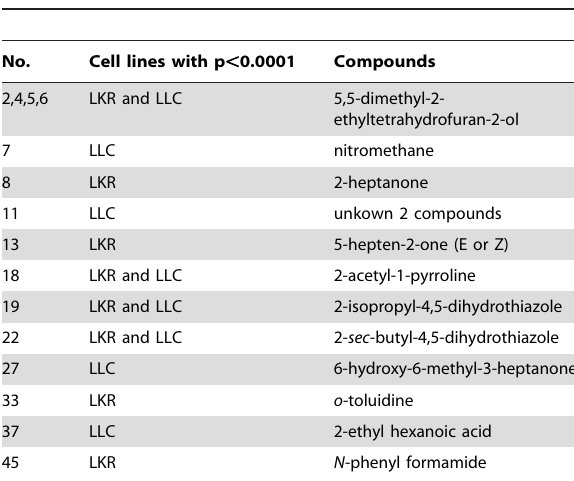
Table 1. Selected peaks and their identifications.